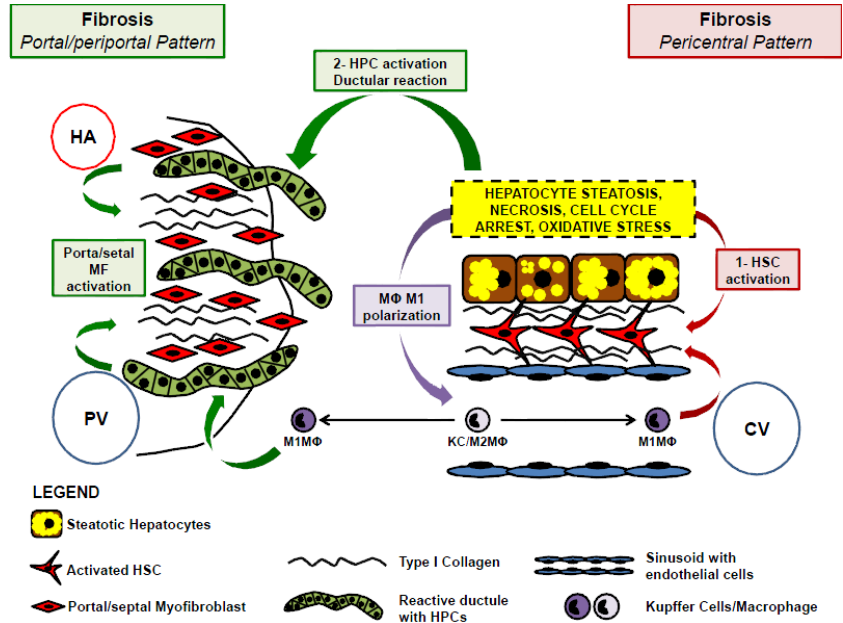
Figure 2. Cartoon indicating possible cellular cross-talks among hepatic stellate cells (HSCs), hepatic progenitor cells (HPCs) and Kupffer cells/macrophage (KC/M Φ ) in NAFLD progression. Two distinct fibrogenic pathways are present in NAFLD. Pericentral fibrogenesis is due to activation of HSCs by damaged hepatocytes. On the other hand, hepatocyte damaging could stimulate HPC proliferation, thus resulting in the appearance of ductular reaction (DR); in turn, DR activates portal myofibroblasts (MF) which are responsible of periportal fibrogenesis. Finally, KC/M Φ polarization toward M1 phenotype could be involved in both pathways since M1-M Φ s are able to stimulate HSCs and HPCs. PV = portal vein; CV = central vein; HA = hepatic